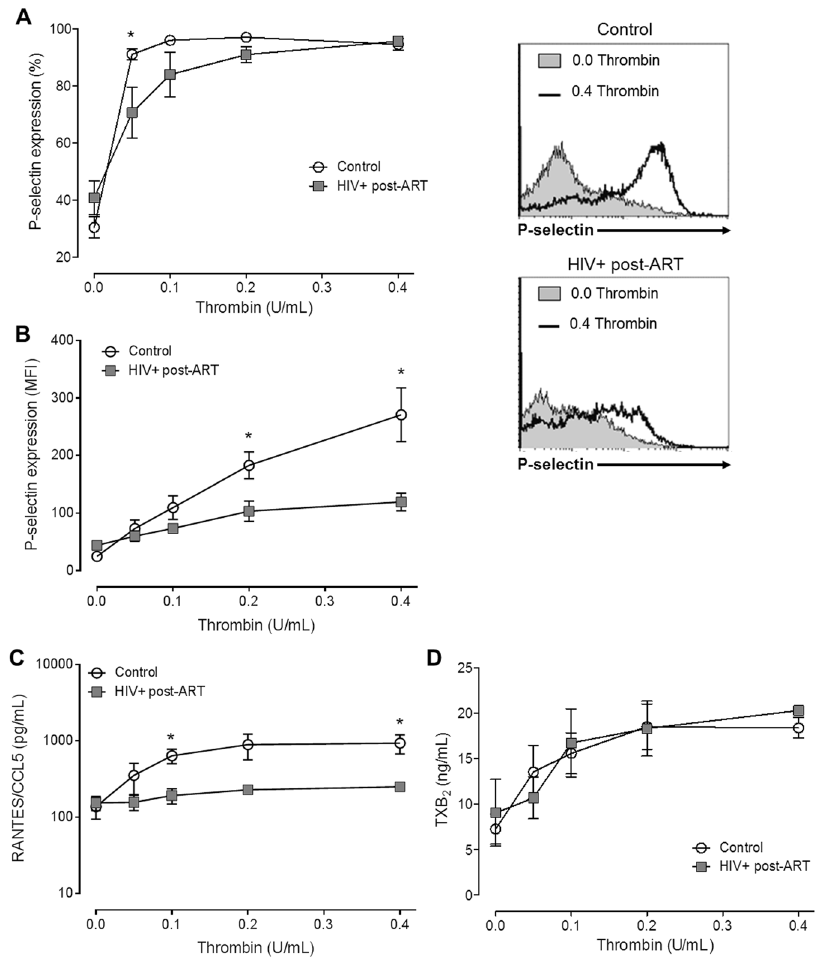
Figure 3. Platelet response to thrombin in platelets from HIV-infected individuals under stable cART and healthy volunteers. ( A , B ) The percentage of platelets with P-selectin surface expression ( A ) and the mean fluorescence intensity (MFI) for P-selectin labeling ( B ) on platelets from healthy subjects (control) or from HIV-infected individuals under viral control (HIV-1 viral load < 50 copies/ml in the peripheral blood) after stimulation with thrombin (0.05 U/mL, 0.1 U/mL, 0.2 U/mL and 0.4 U/mL). ( C,D ) The concentration of RANTES ( C ) or thromboxane B 2 ( D ) in the supernatant of platelets from control or HIV-1-infected subjects stimulated with each concentration of thrombin. The dots indicate the mean ± standard error of the mean of 5–10 HIV-infected individuals or healthy volunteers. Representative histograms are shown. The asterisk ( * ) signifies p < 0.05 between platelets from control or healthy volunteers stimulated with the same concentration of